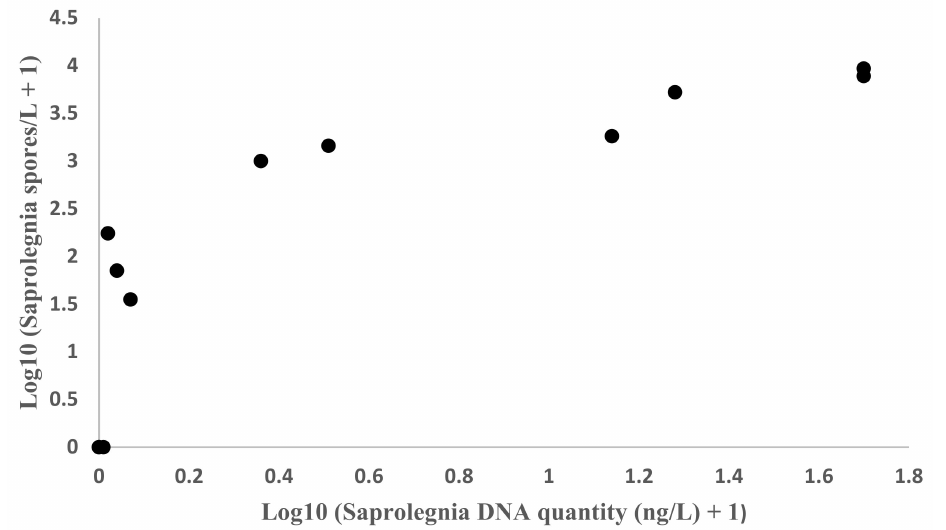
Figure 2. Correlation between the quantity of S. parasitica DNA (ng/L) determined with qPCR and the quantity of Saprolegnia sp. spores (spores/L) determined using MWP (values for tank 1a excluded as the MWP result could not be determined from the tank water sample, n = 12), Pearson’s correlation coefficient 0.82, p =